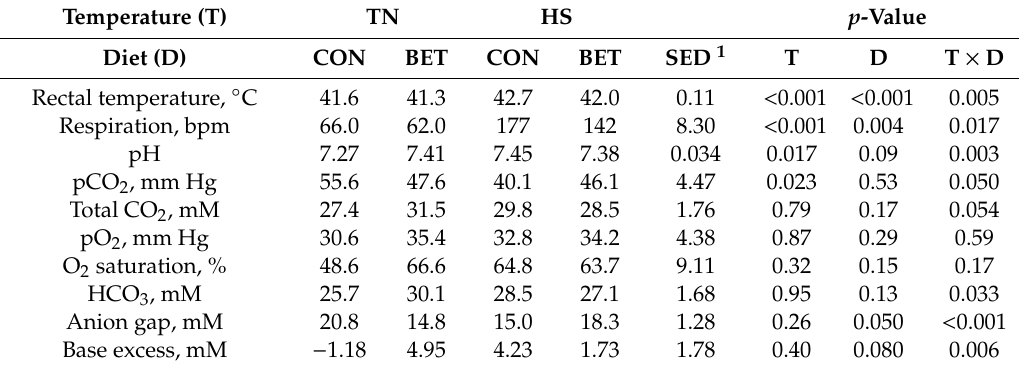
Table 2. E ff ect of betaine (BET) on rectal temperature, respiration rate, acid / base balance and blood gas during thermoneutral (TN) and heat stress (HS) conditions.